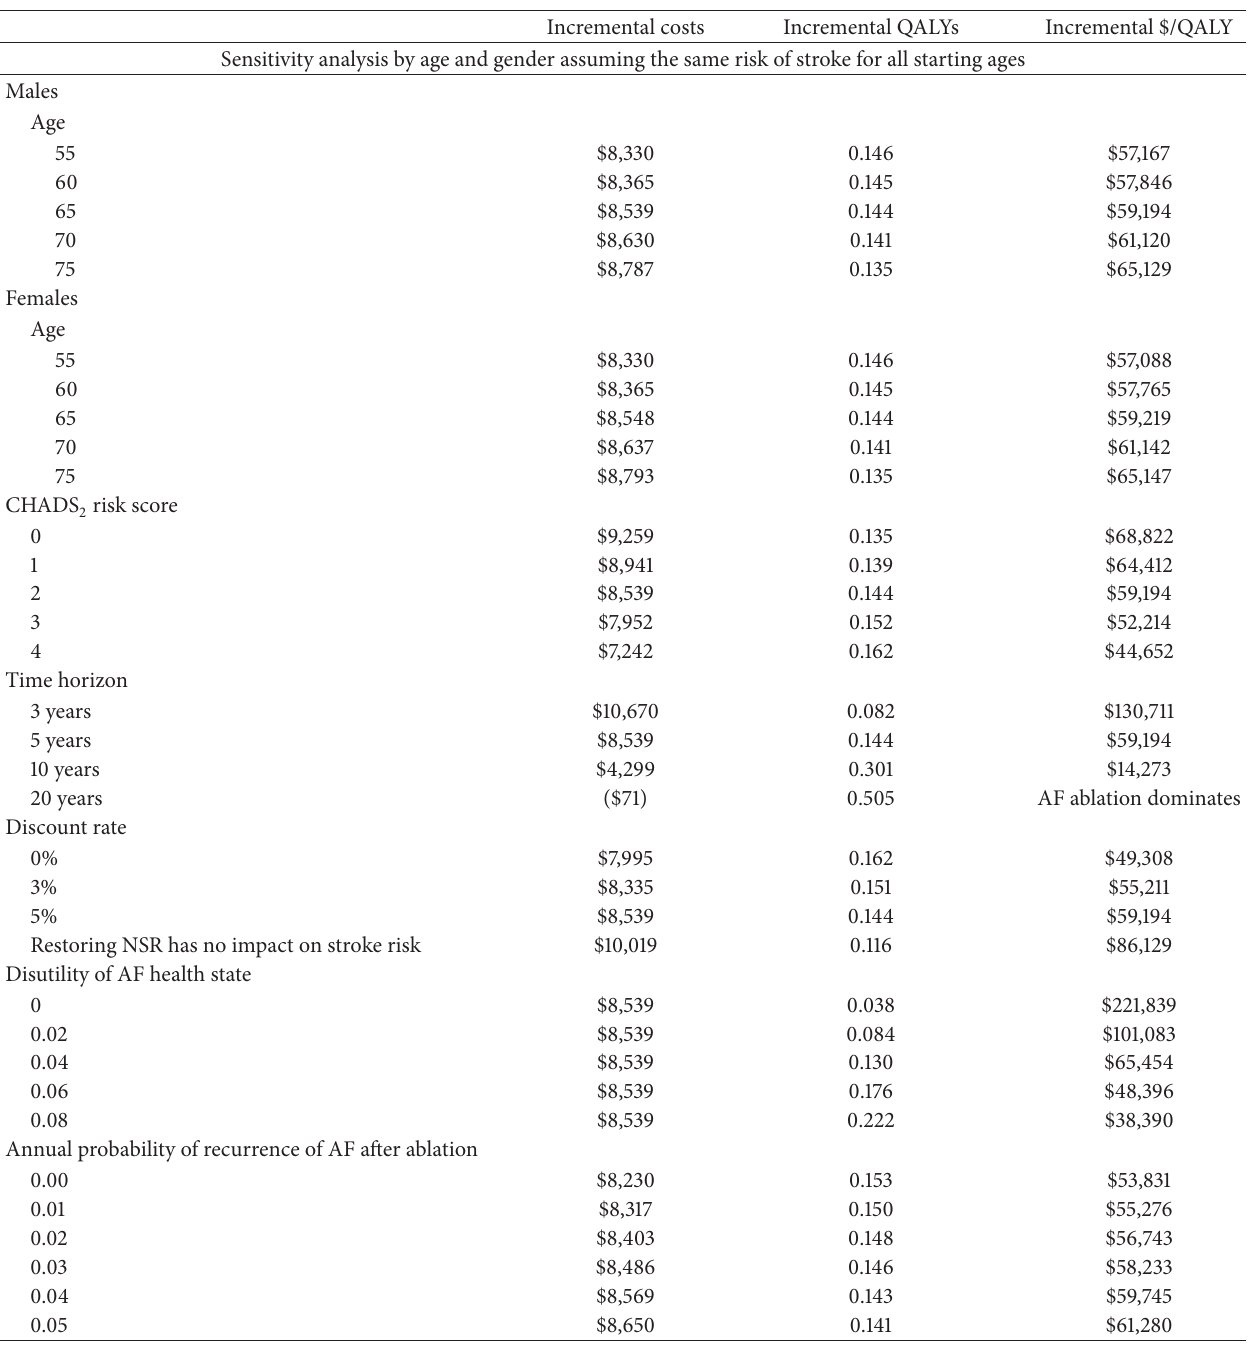
Table 4: One-way sensitivity